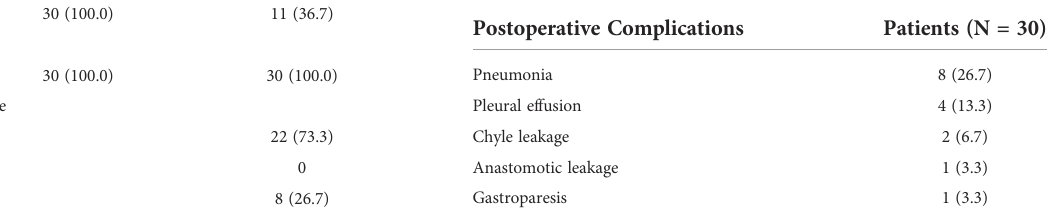
TABLE 5 Postoperative complications. No.